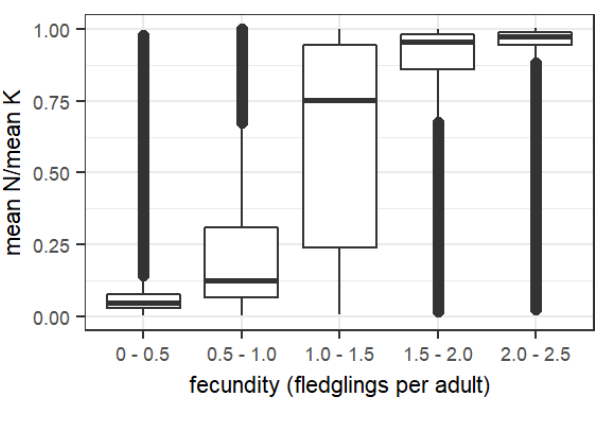
Fig. 4 . Effect of Least Bell’s Vireo fecundity (fledglings per adult; postcowbird control) on ratio of mean population size, number (N) of pairs, to mean carrying capacity